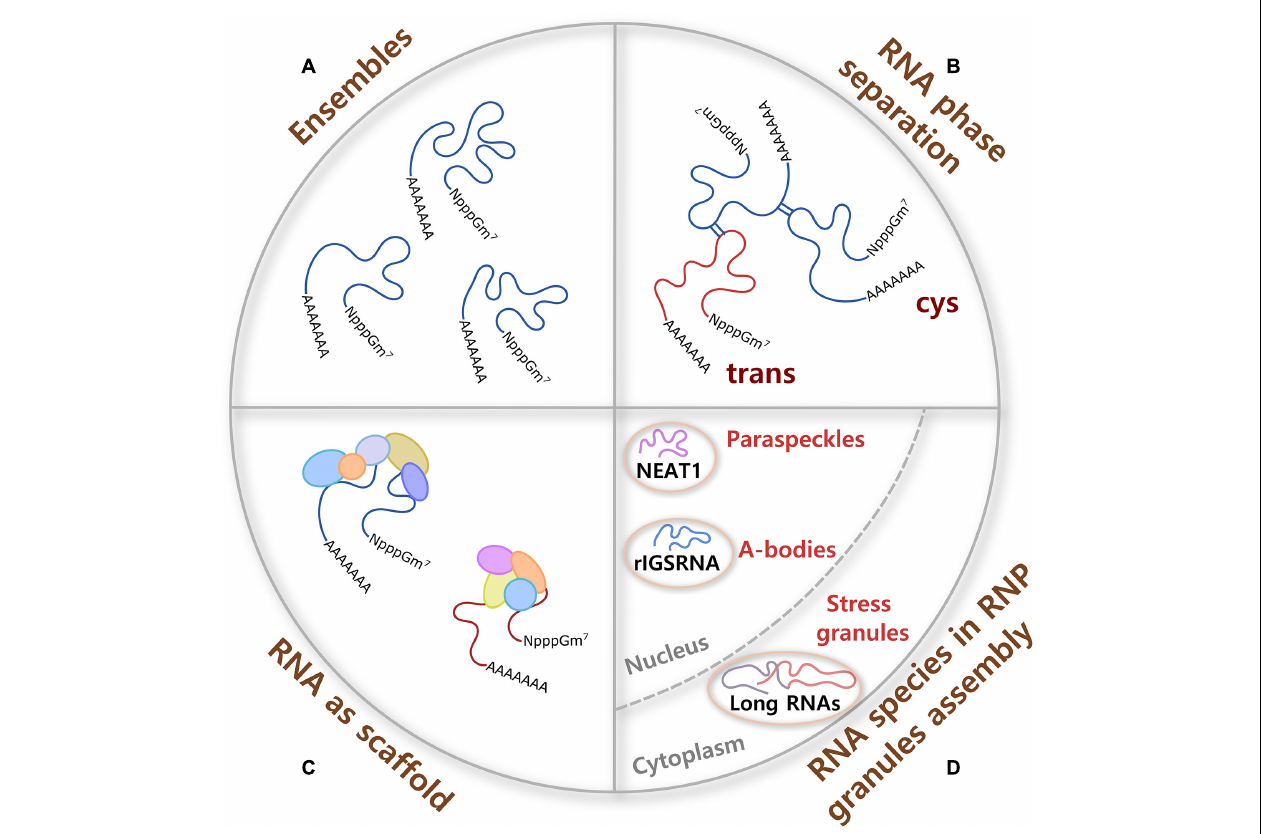
FIGURE 1 | RNA contributions to RNP granule formation. (A) A single molecule of RNA can adopt different conformations called ensembles, some of them formed with high probability and others not, which provide flexibility to form multivalent interactions and the potential to have different molecular functions. (B) Cis and trans RNA–RNA interactions participate in RNA phase separation in the absence of proteins. RNA interactions are specific or promiscuous, and are modulated by ionic strength, osmolarity, pH, temperature, and crowdedness. (C) Because of their large size, RNA molecules are better scaffolds for multiprotein complex formation than proteins. RNA–protein interactions are formed through negatively charged phosphate groups of RNA and different RNA-binding proteins (RBPs). (D) Certain ribonucleoprotein (RNP) granules require specific RNA species for their assembly. In the nucleus, non-coding RNAs nuclear paraspeckle assembly transcript 1 (NEAT1) and RNA derived from the rDNA intergenic spacer (rIGSRNA) are necessary for the formation of paraspeckles and A-bodies, respectively. In the cytoplasm, even though no specific RNA molecule is required for stress granule (SG) assembly, long coding and non-coding RNAs form extended RNA–RNA networks that are necessary for SG